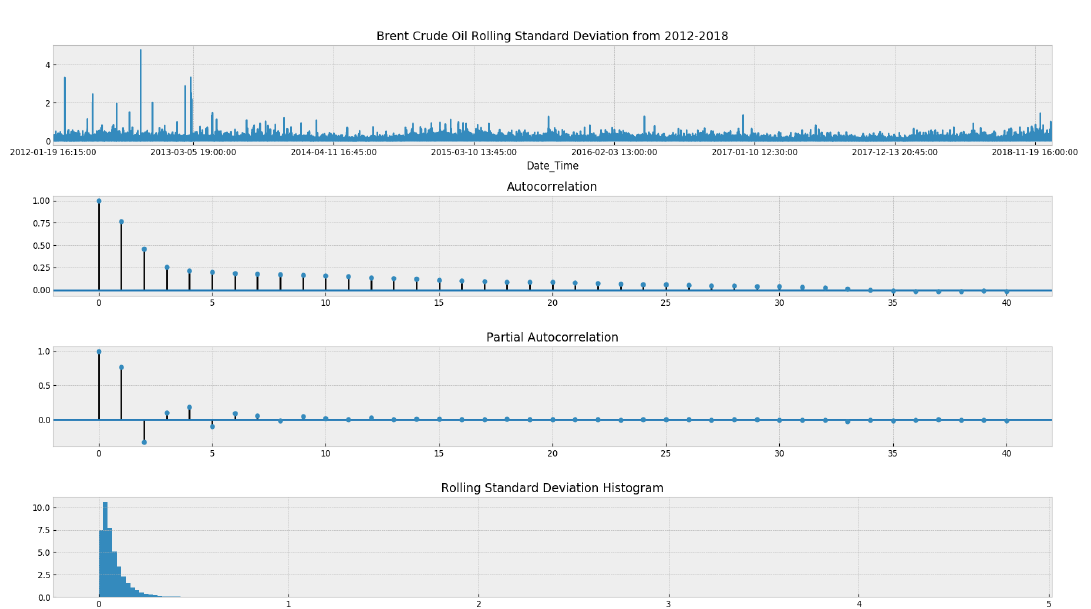
Figure 2: Brent Crude Oil 1 hour window of rolling standard deviation (Jan. 2012 - Dec. 2018), original raw price data; ACF/PACF- and Histogram-plot; Source : Faseli,